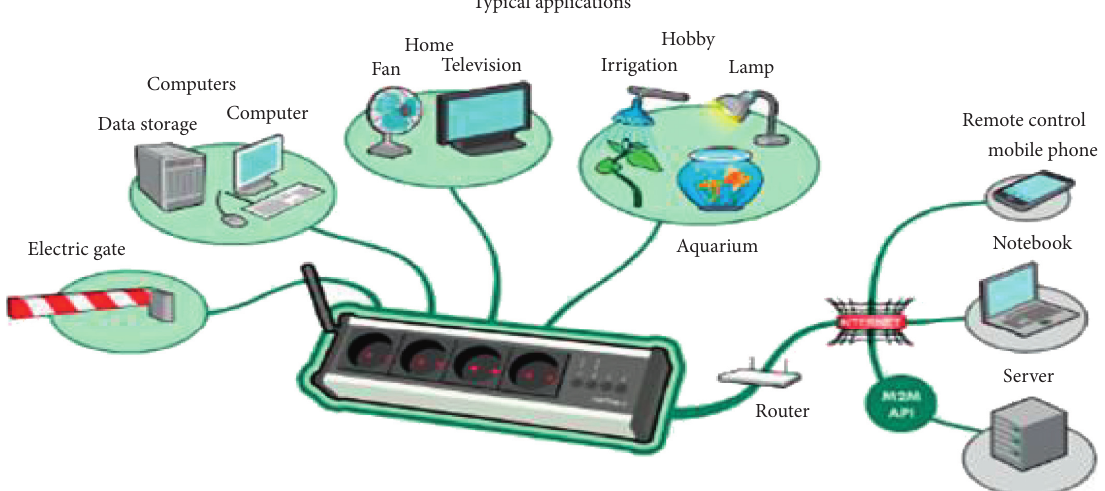
Figure 1: Application of electric sockets in real life.